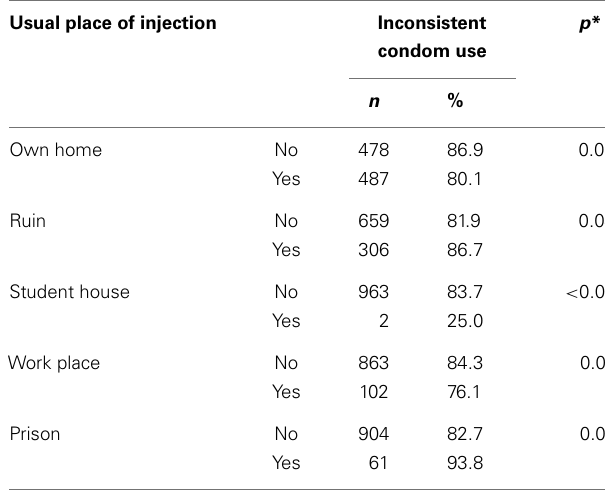
Table 1 |Associations between socio-economic data and inconsistent condom use .